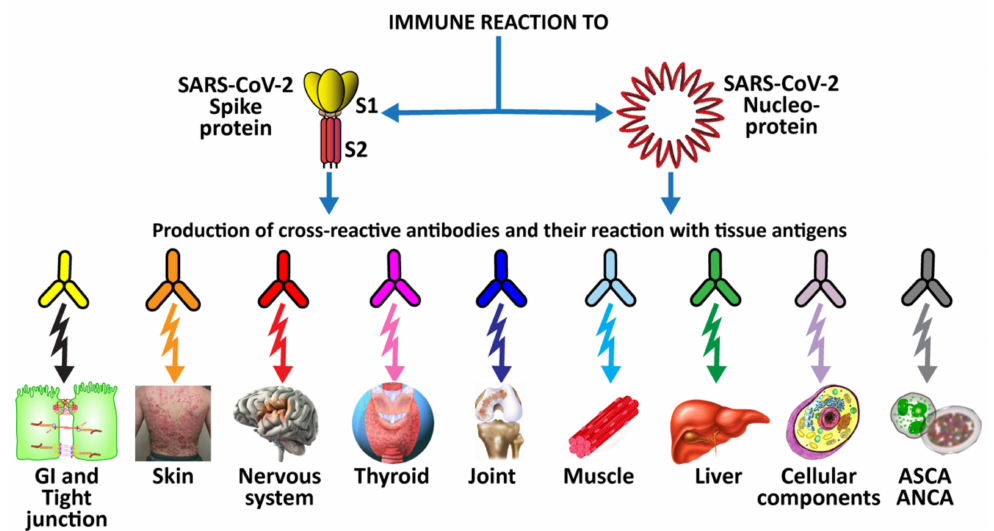
Figure 5. Diagram of possible relationship between SARS-CoV-2 proteins and autoimmune target